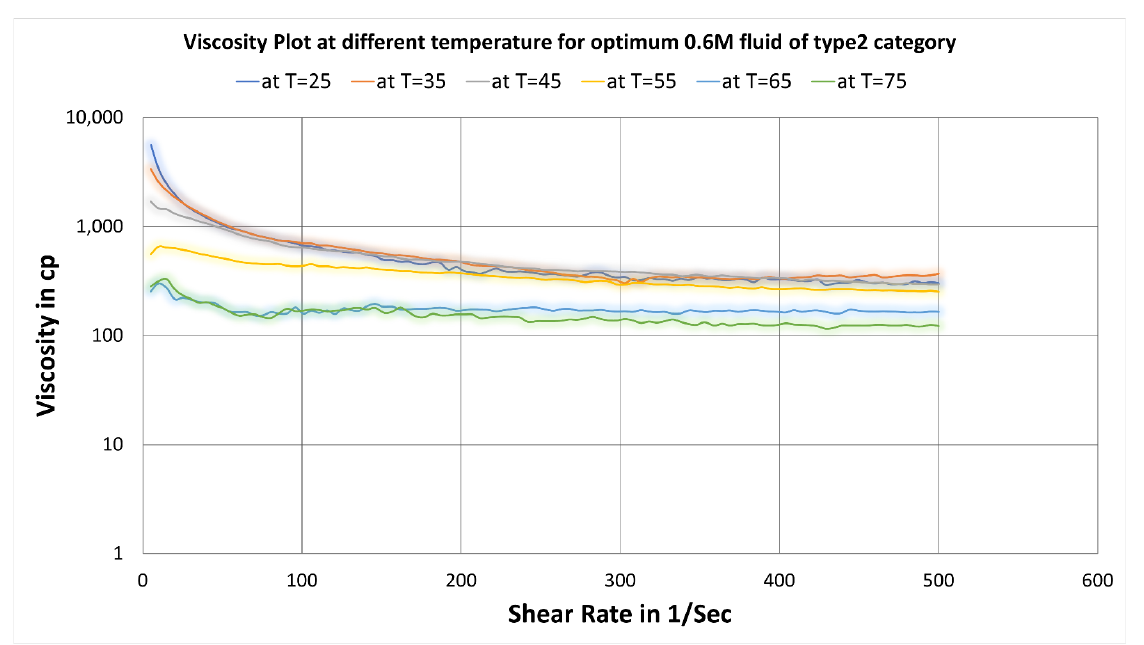
Figure 9. Change in viscosity plot of optimum concentration (0.6 M) fluid of type1 fluids at vary- ing temperatures.